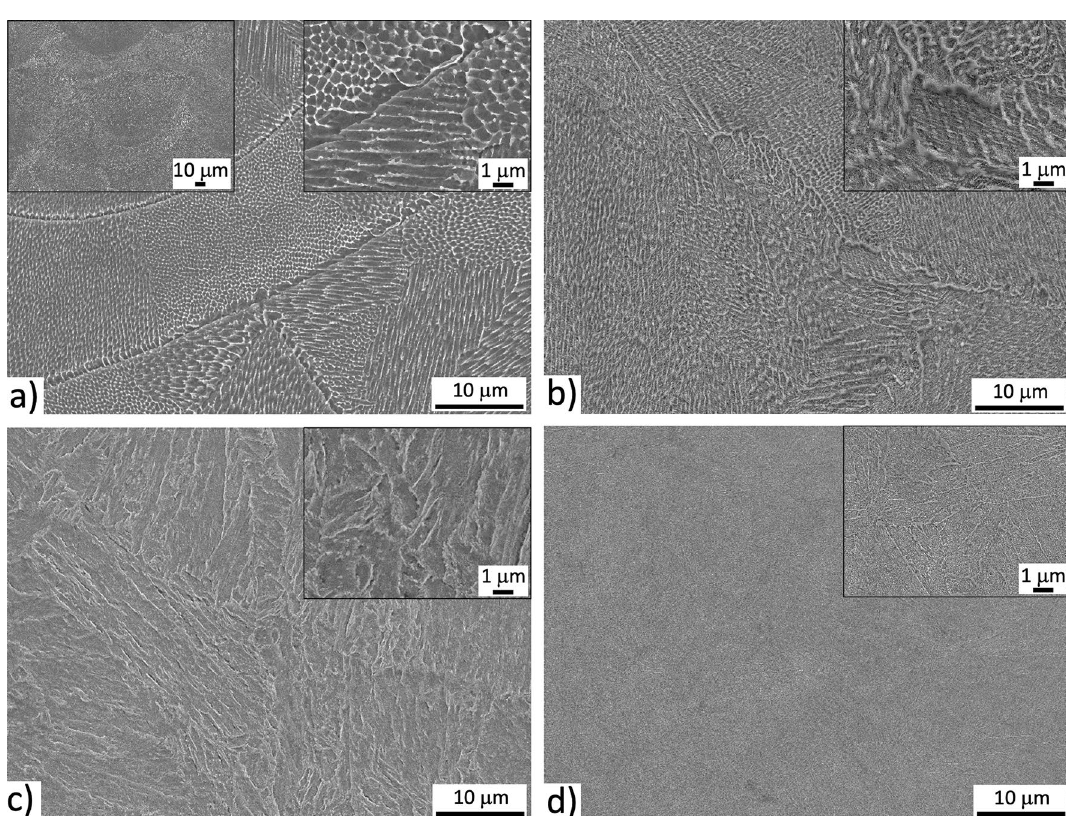
Figure 2. SE images of bulk microstructures of: ( a ) AM, ( b ) AM + DAT, ( c ) AM + SAT and ( d ) CM + SAT samples with insets of higher magnification; etched in